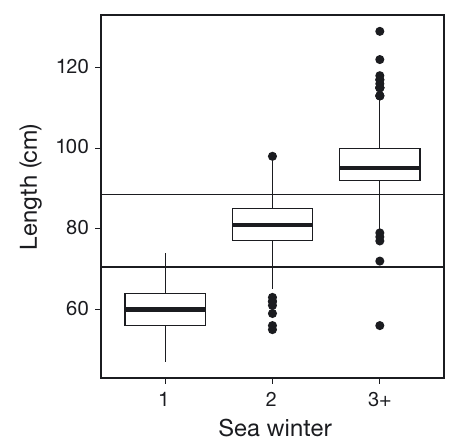
Fig. 2. Size classification of Atlantic salmon net captures based on sea winter age. Solid horizontal lines: length breaks into small, medium, and large size classifications. Boxes: in- terquartile range (IQR); horizontal lines in the boxes: median values; whiskers: 1.5 times the IQR; solid circles: